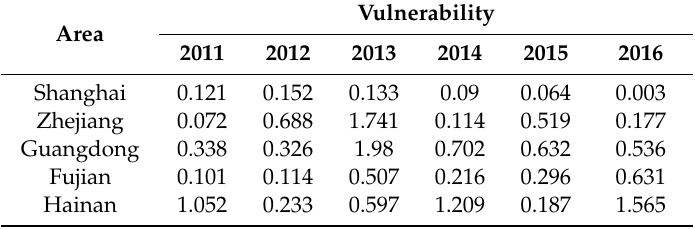
Table 2. The vulnerability to typhoon disasters of selected areas from 2011 to 2016.